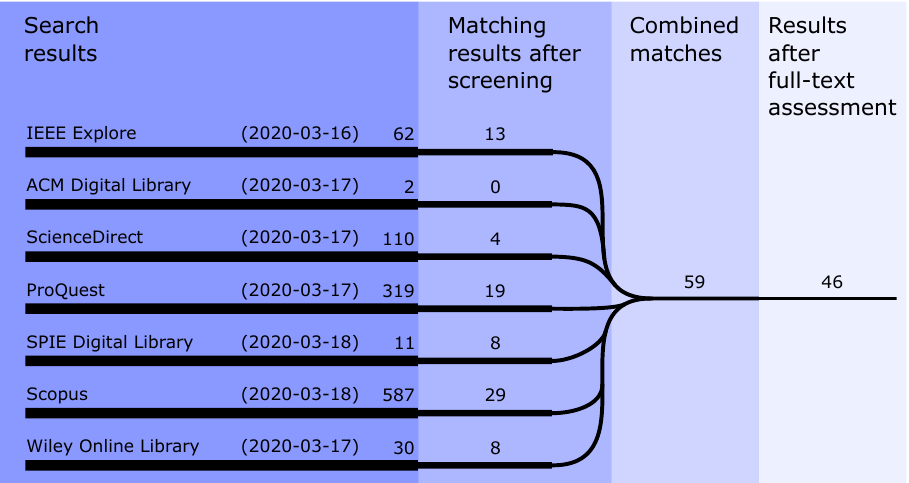
Figure 1. Flow of the literature search. The records of the seven scholarly databases are manually screened based on the title, abstract, and keywords. In a subsequent stage, the records are combined and checked for duplicates. In the final process (light blue), the full-text of every record is manually